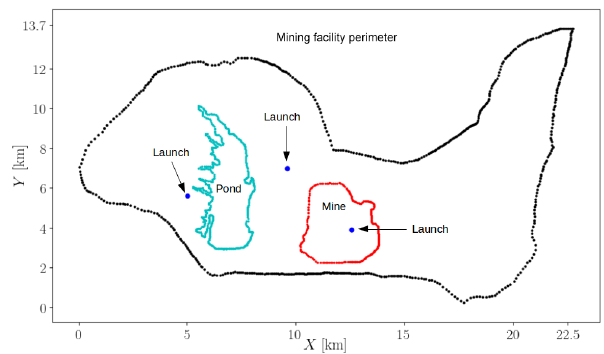
Figure 4. A schematic of the mining facility; the black dots repre- sent the outline of the entire facility. The green dots represent the outline of the tailings pond, and the red dots represent the outline of the mine. The blue dots are the balloon launch